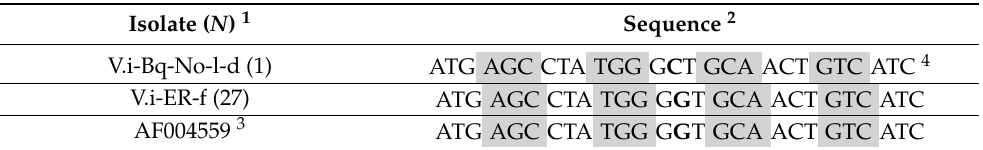
Table 7. Partial sequences of cytochrome b ( CYTB ) gene region representing isolates sensitive and resistant to QoI